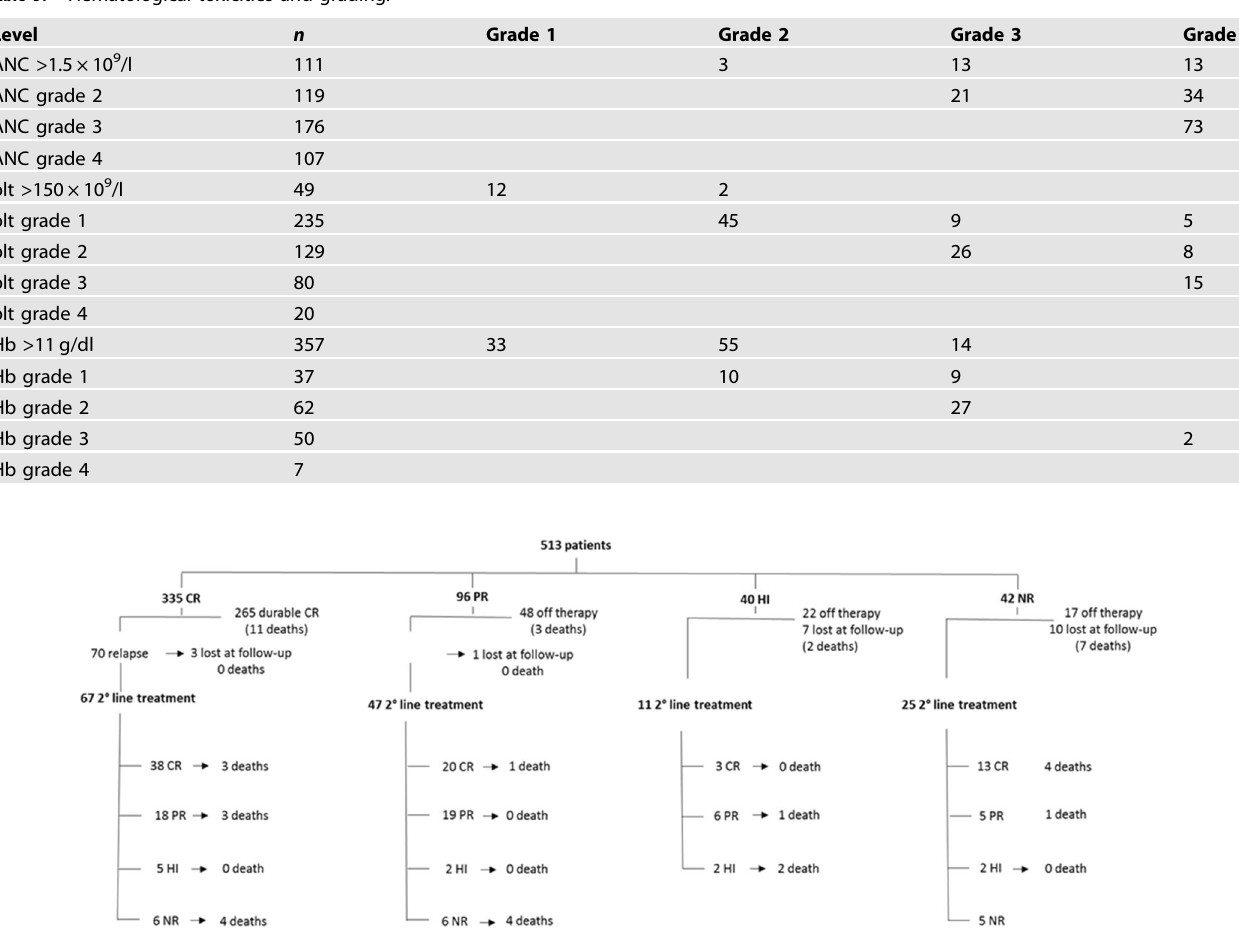
Table 5. Hematological toxicities and grading.